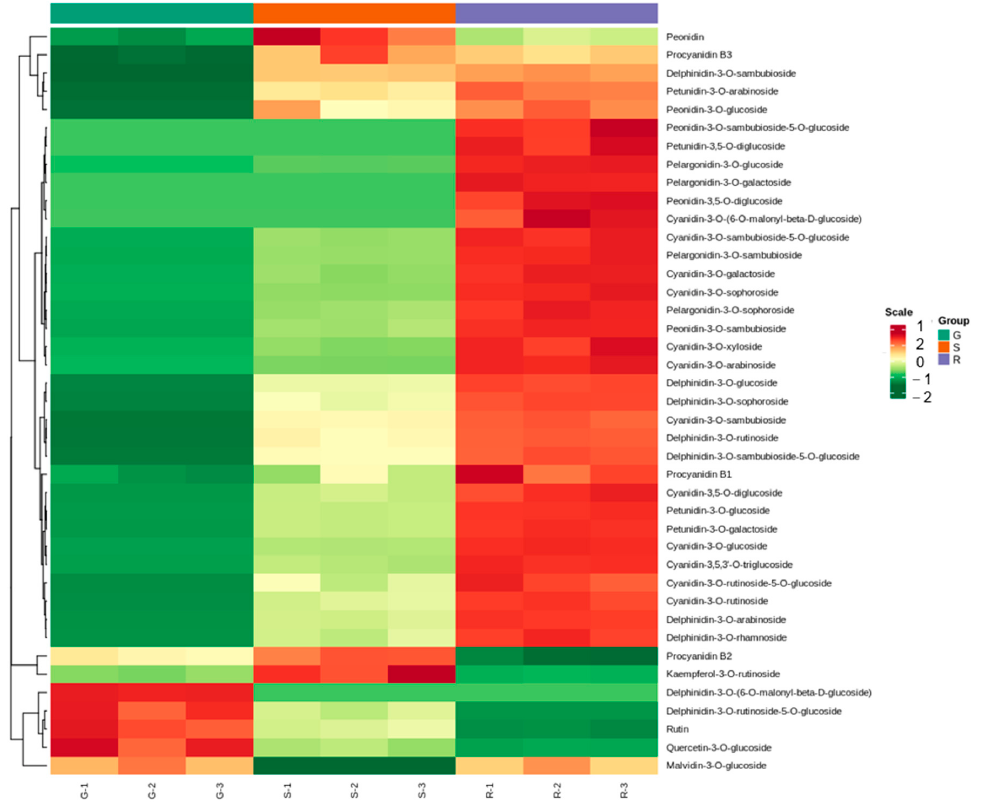
Figure 2. Heat map showing the contents of 41 flavonoids and anthocyanins in different cultivars. The abscissa is the three repeats of different roselle cultivars, and the ordinate indicates the types of anthocyanins and flavonoids. Red color represents high content, whereas green represents low content; yellow color indicates intermediate content. R, FZ-72 (red calyx); G, Baitao K (green calyx); S, MG5 (stripped